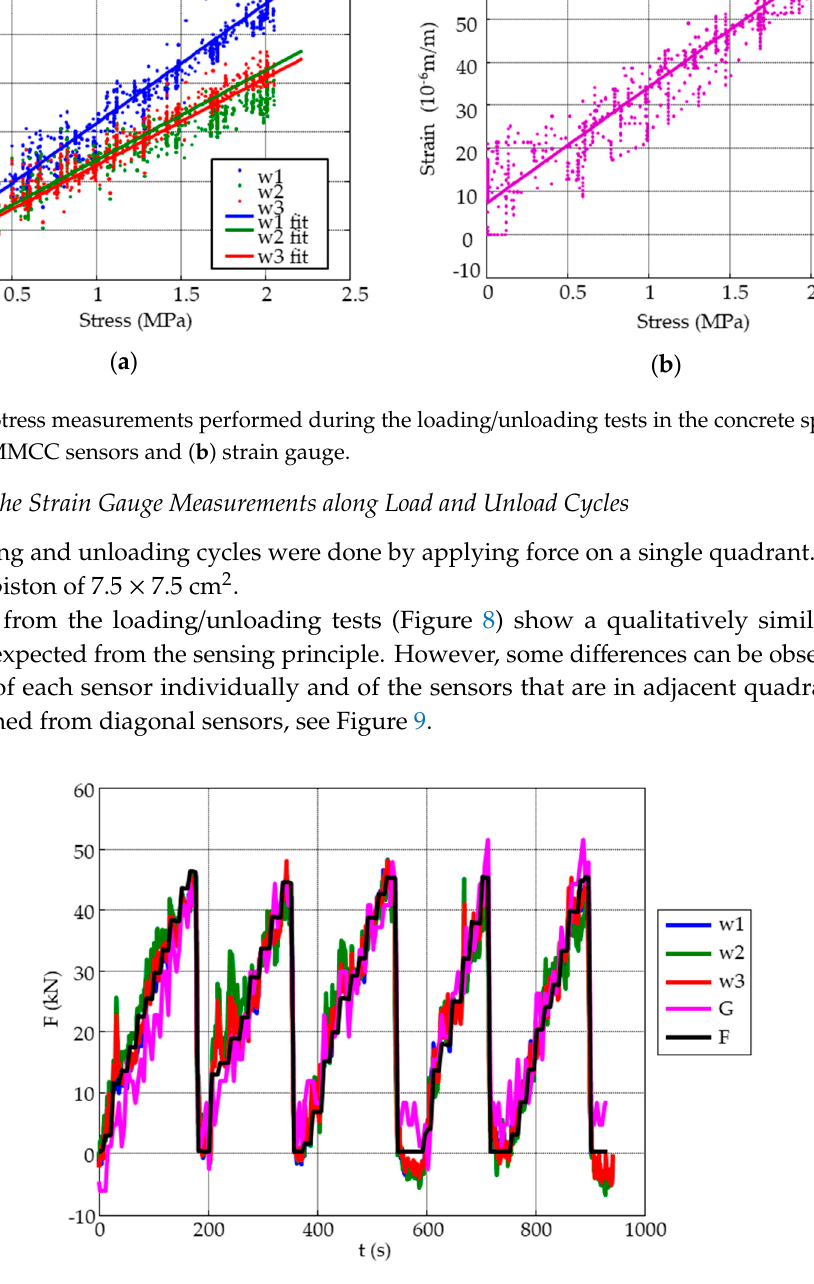
Figure 7. Stress measurements performed during the loading/unloading tests in the concrete specimen using ( a ) MMCC sensors and ( b ) strain gauge.